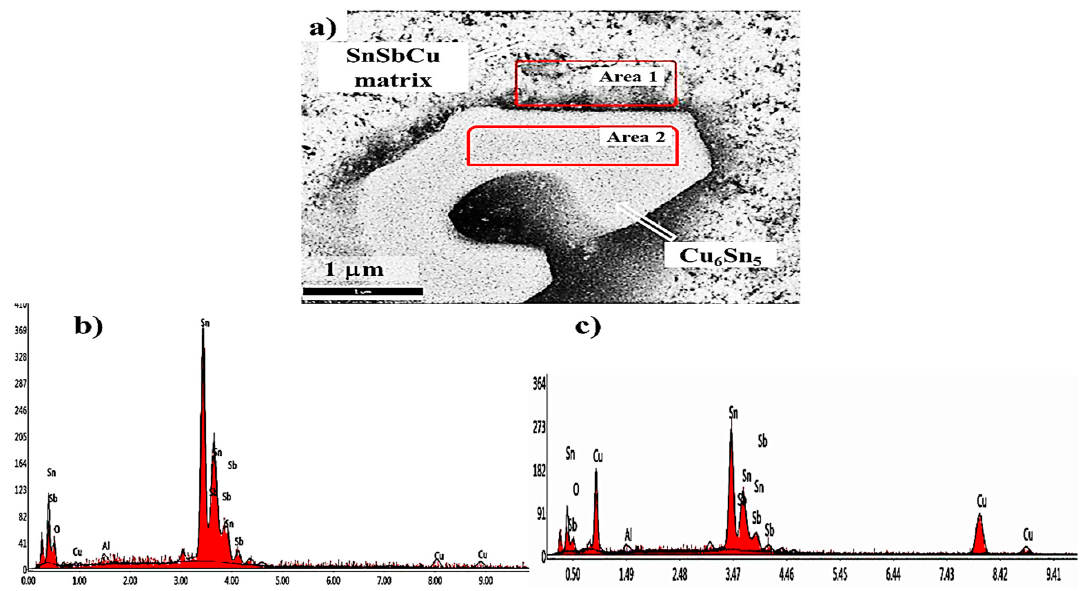
Figure 8. ( a ) SEM image of tin-based Babbitt alloy nanocomposite containing 0.5 wt% alumina nanoparticles, ( b ) and ( c ) graphical presentation of EDS results at two selected areas of matrix and Cu 6 Sn 5 Phase consequently.